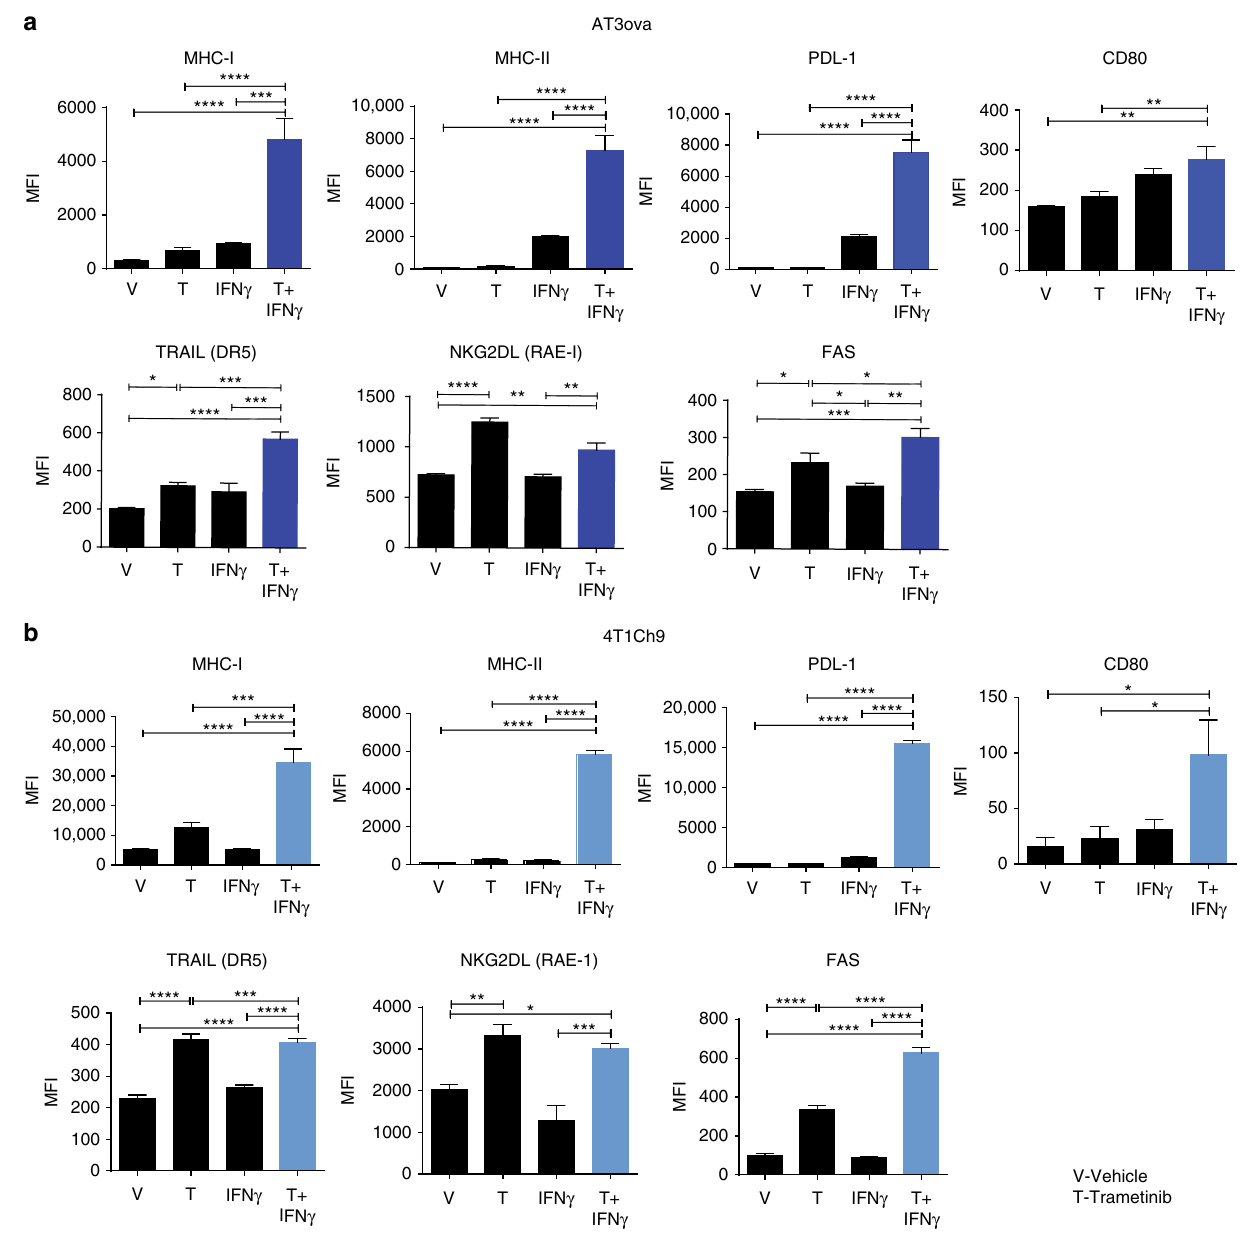
Fig. 2 MEK inhibition increases tumor immunogenicity of AT3ova and 4T1Ch9 TNBC tumors in vitro. FACS analysis of MHC-I, MHC-II, PDL-1, CD80, TRAIL (DR5) NKG2DL (RAE-1), and Fas expression ( MFI ; mean fl uorescence index) on the a AT3ova and b 4T1Ch9 murine TNBC cell lines following trametinib treatment alone (100 nM), IFN γ stimulation alone (5 ng/ml), or combination of trametinib treatment and IFN γ stimulation. Data are presented as mean ± SEM of triplicate samples. P -values represent one-way ANOVA and post hoc Fisher ’ s LSD tests. * P < 0.05, ** P < 0.01, *** P < 0.001, **** P <